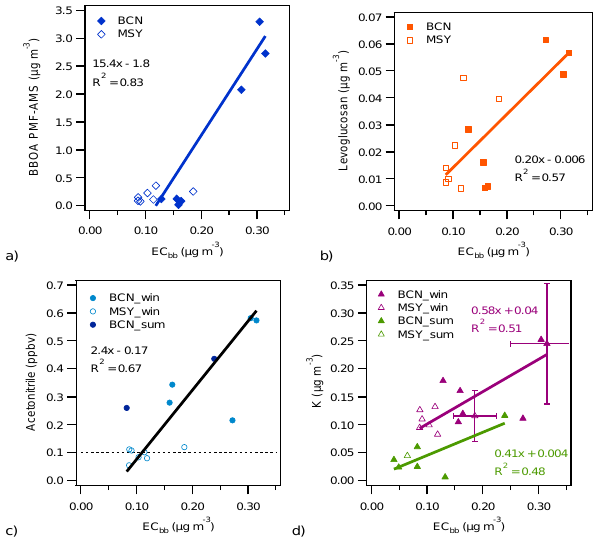
Fig. 8. Scatter plot of (a) biomass burning organic aerosol contri- bution estimated from PMF-AMS vs. biomass burning elemental carbon estimated by 14 C method (EC bb ) in DAURE-W; (b) lev- oglucosan concentrations (average of lev-HAS and lev-ISAC mea- surements) vs. EC bb in DAURE-W; (c) K concentrations vs. EC bb in DAURE-W (purple) and DAURE-S (green), error bars indicate measurement uncertainty, only shown for two data points for clar- ity; (d) acetonitrile concentrations vs. EC bb in DAURE-W; dotted line indicates typical continental background acetonitrile concen- trations (although lower background values are possible for air with recent contact with the ocean). Correlation coefficients were calcu- lated using all data points shown in the plots. Regression lines were calculated with orthogonal distance